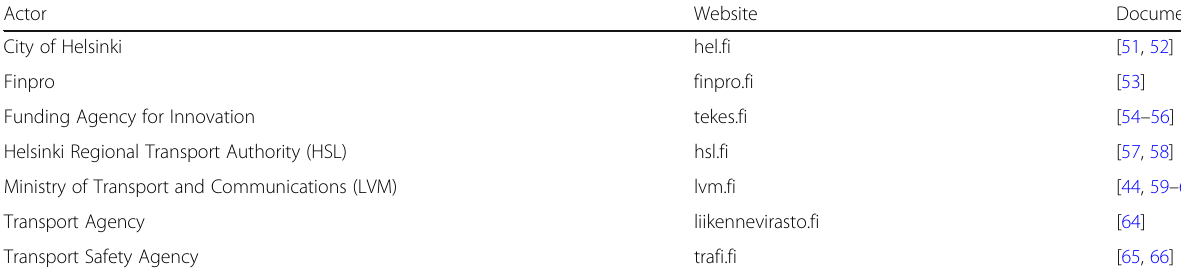
Table 1 Documents and websites reviewed in the Finnish Case Actor